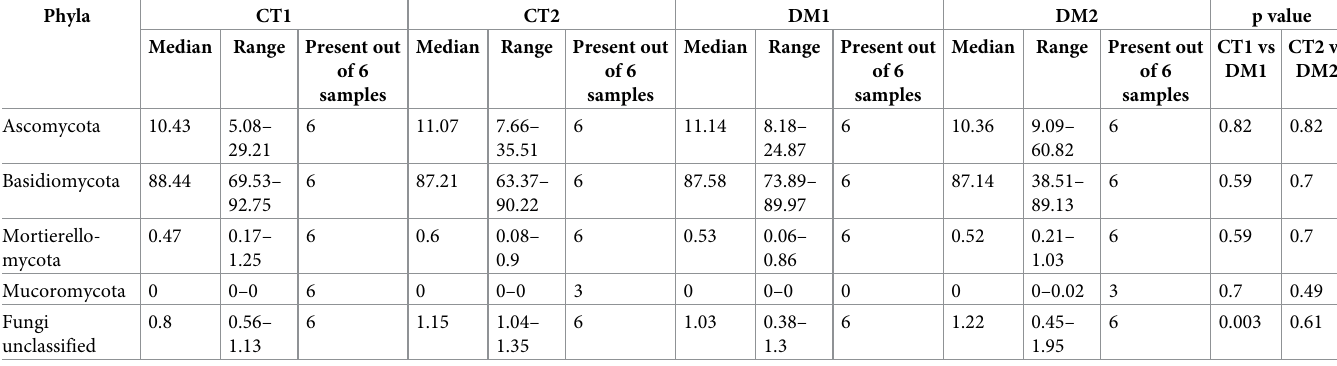
Table 1. Comparison of the median abundance (%) of fungal phyla in the gut mycobiomes of diabetic rats after 1 (DM1, n = 6) and 2 months (DM2, n = 6) with con- trol rats after 1 (CT1, n = 6) and 2 months (CT2, n = 6) respectively.